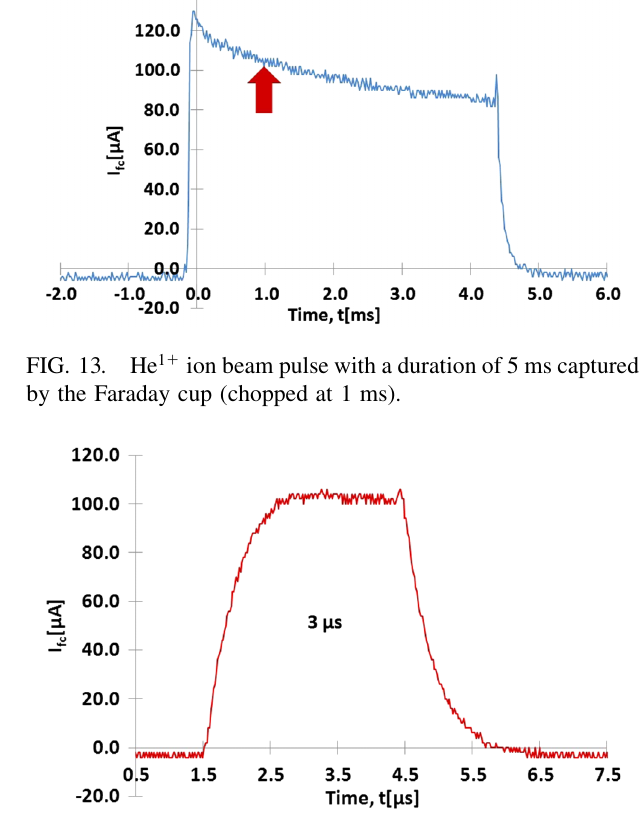
FIG. 14. Chopped beam pulse with a duration of 3 (cid:1) s